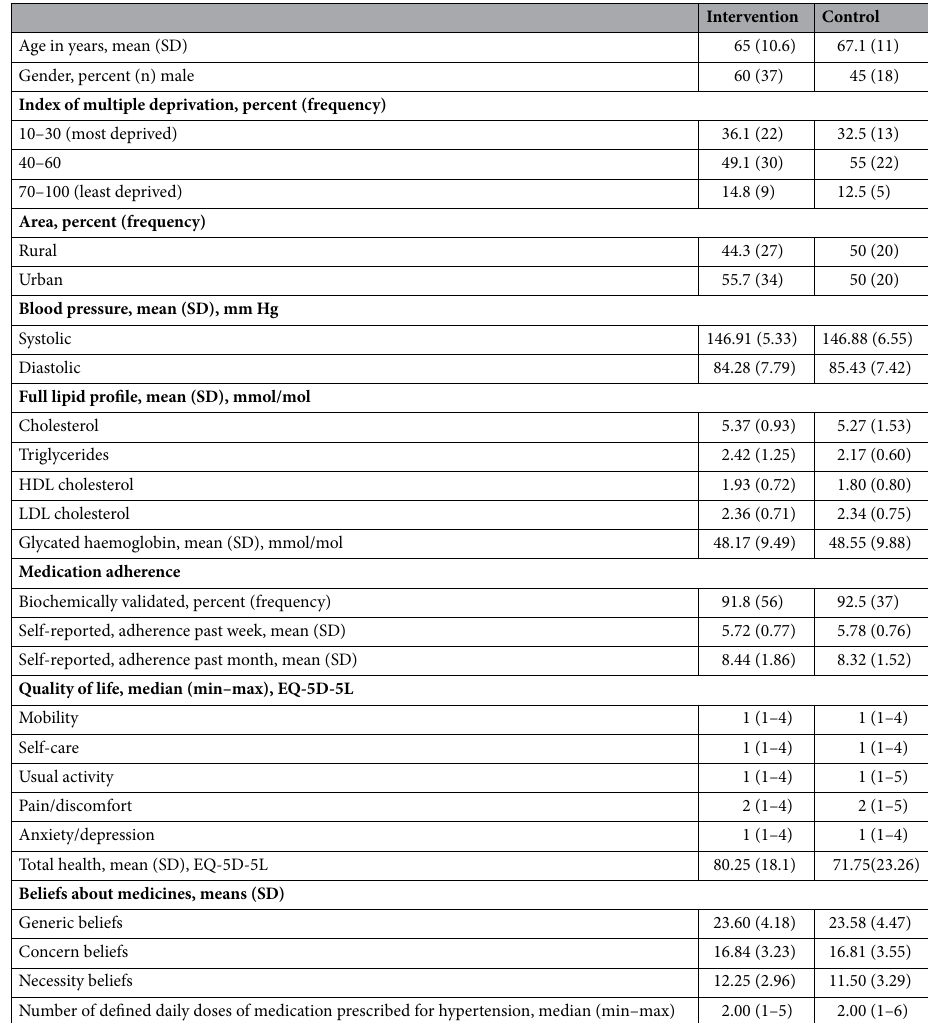
Table 1. Baseline characteristics of randomised patients. N = 101 (n = 61 intervention, n = 40 control); blood pressure, urine samples, self-report medication adherence, Quality of Life EQ-5D-5L and Beliefs about Medicines Questionnaire. Of whom N = 42 full lipid profile (n = 28 intervention, n = 14 control) and N = 34 glycated haemoglobin (n = 23 intervention, n = 11 control). English Index of Multiple Deprivation was calculated based on practice post code. Scores range from 10 to 100. Most deprived were those located at 10–30% most deprived areas; middle deprived were those located at 40–60% least deprived areas, and least deprived were those located at 70%-100% least deprived areas. Quality of Life five dimensions score range from 1 to 5. Lower scores indicate better Quality of Life. Total health scores range from 0 to 100. Higher scores indicate better total health. Beliefs about Medicines total scores range from 5 to 25. Higher scores indicate more positive beliefs. Number of prescribed anti-hypertensives is per defined daily dose. Data are reported as percentages and frequencies, median with minimum (min) and maximum (max) values, or means with standard error (SE) and standard deviations